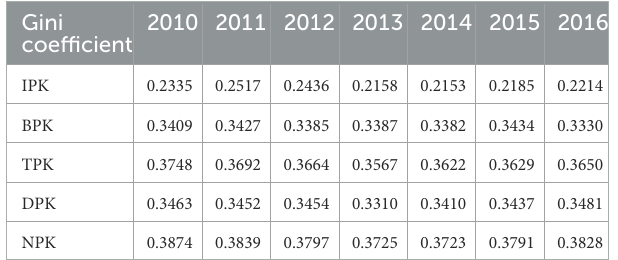
TABLE 2 Trends of the Gini coefficients for the health resources in Shanghai at municipal level from 2010 to